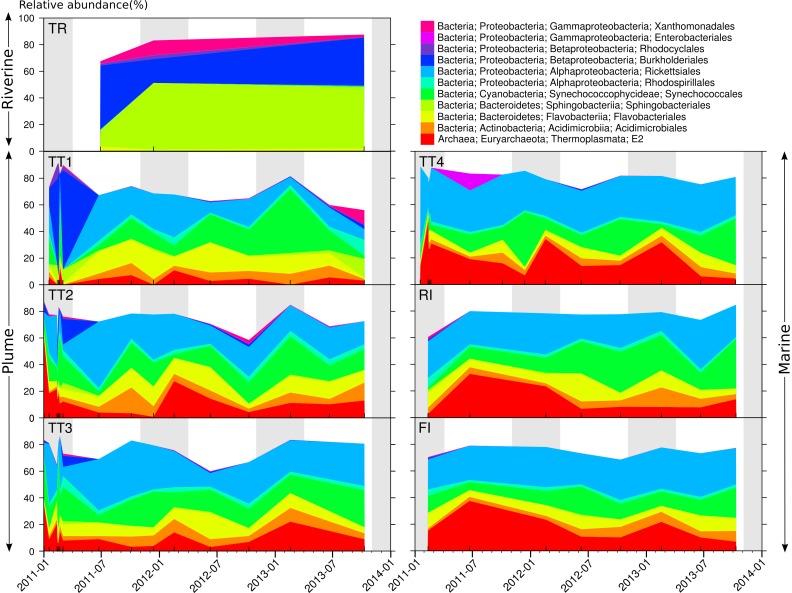
Distribution and dynamics of abundant microbial orders for the seven sites surveyed in 2011, 2012–2013.Microbial orders present at less than 10% relative abundance in all samples were omitted. The shading represents the extent of the wet season.